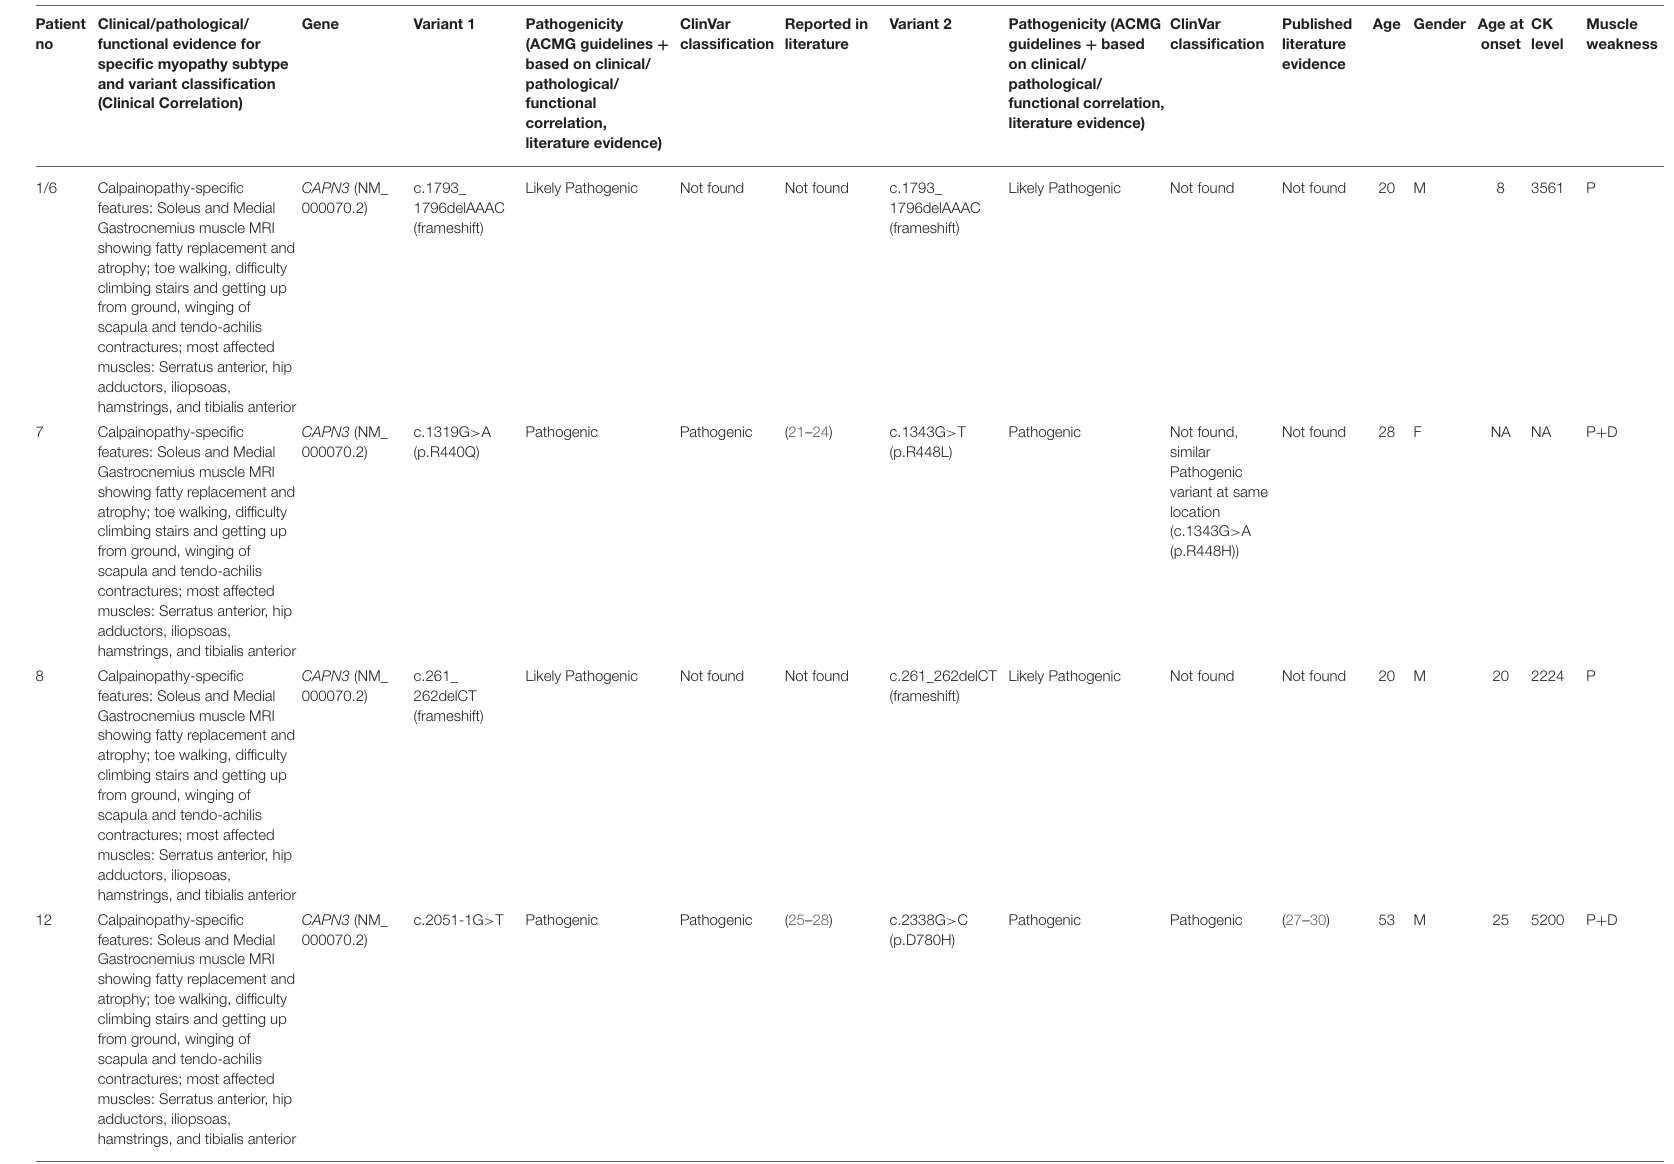
TABLE 1 | Molecular and Clinical aspects of CAPN3 , DYSF , and GNE patients. Patient Clinical/pathological/ no functional evidence for specific myopathy subtype and variant classification (Clinical